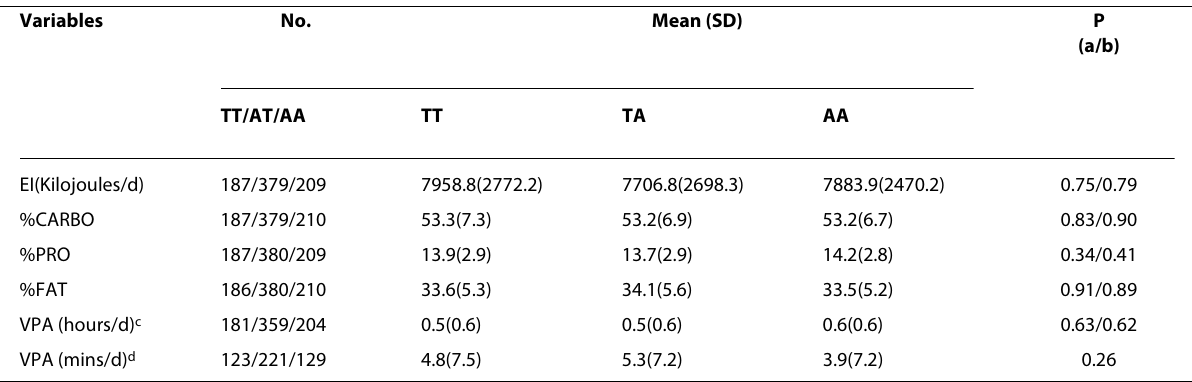
Table 4: Association of rs9939609 with energy intake, percentage of energy intake from carbohydrates, protein and fat and vigorous physical activity measured through recall and accelerometry